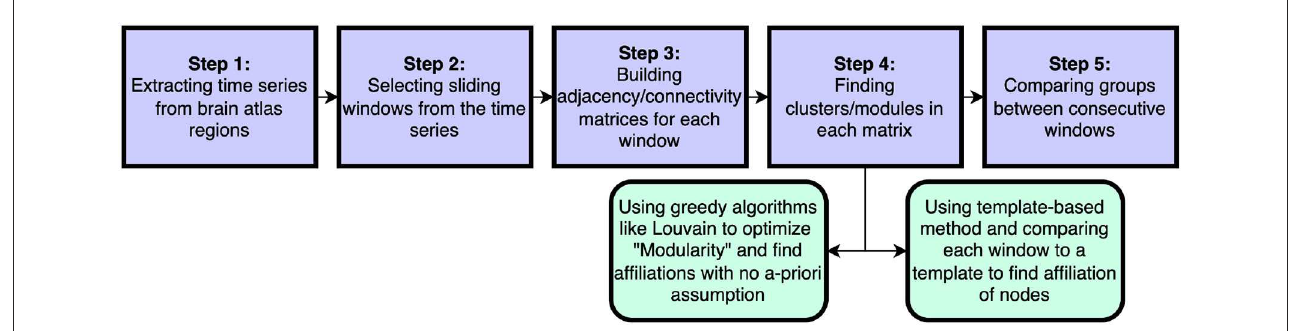
FIGURE8 Schematic steps to calculate dynamical flexibility. The time series are extracted from brain scans. Selected sliding windows are used to generate adjacency/connectivity matrices. The groups/clusters/modules are found in each matrix ∗ using a feasible clustering method. In this step, the method of choice can be a well-known method like the optimization of Newman’s modularity Q using greedy Louvain algorithm or it can be our template-based method that considers the a-priori information about brain as pre-assumption. Finally the assigned affiliations in windows are compared and the differences are found. * In some methods, different sliding window matrices are put together to make a multi-layer network and then an adjusted version of modularity optimization is employed to find module through all